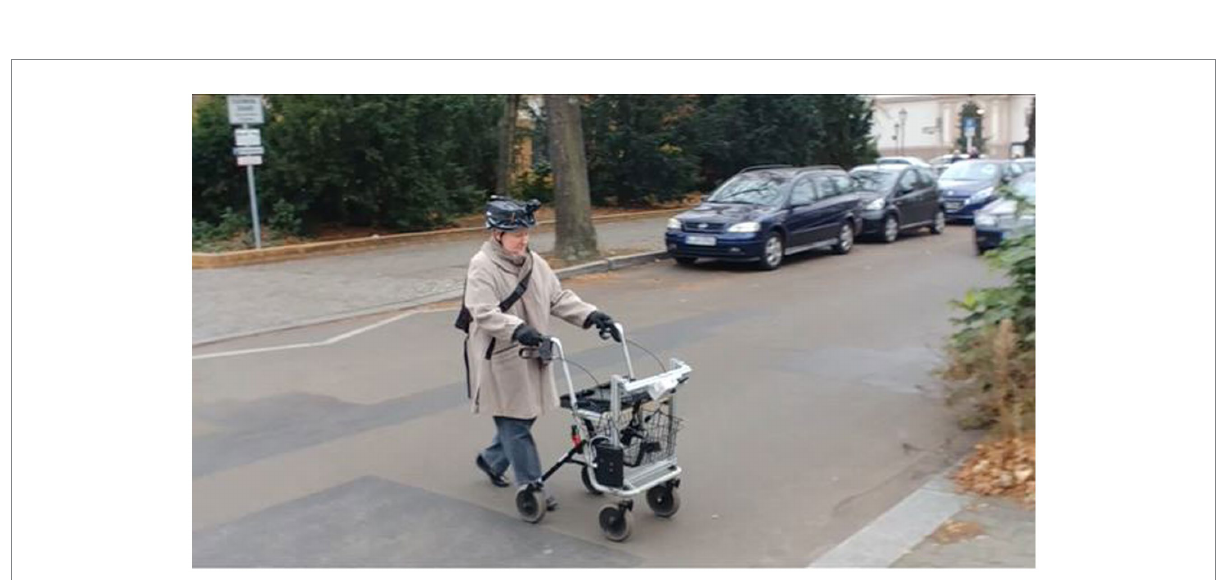
FIGURE 8 Participant in the field study using the walker with the assistance system at an unmarked